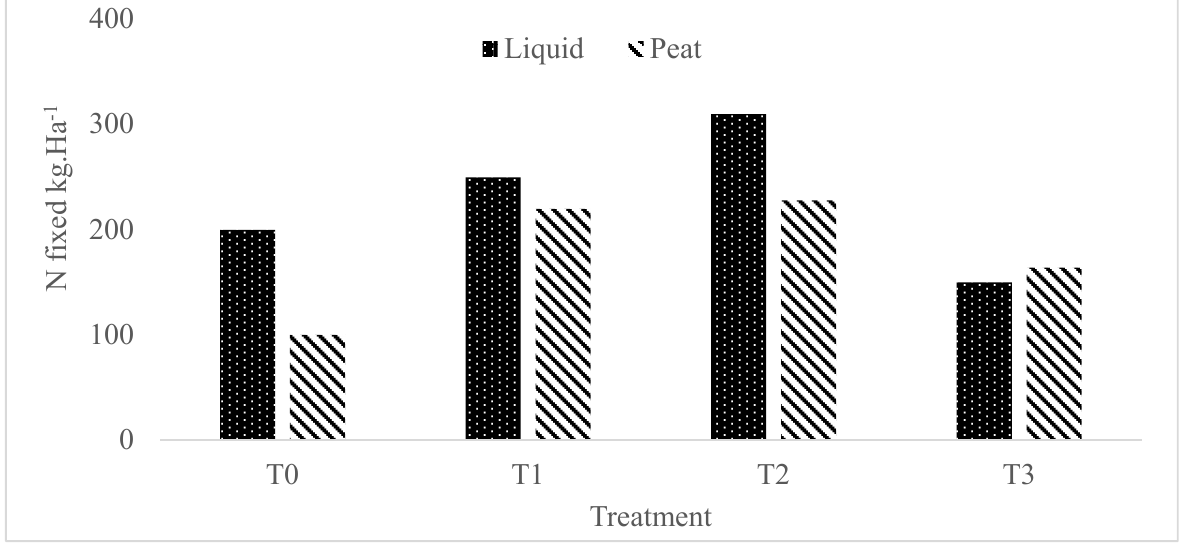
Figure 7. Nitrogen concentrate in soybean plants subjected to liquid formulation (T0 = 0 mL, T1 = 150 mL, T2 = 300 mL and T3 = 150 mL) and peat formulation of Bradyrhizobium japonicum (T0 = 0 mg, T1 = 250 mg, T2 = 500 mg and 150 mL) in bioclimatic zone (( A ) = Bronkhorspruit/Gauteng) and (( B ) = Hartbeesfoein/North West province). Data are means ± standard errors.